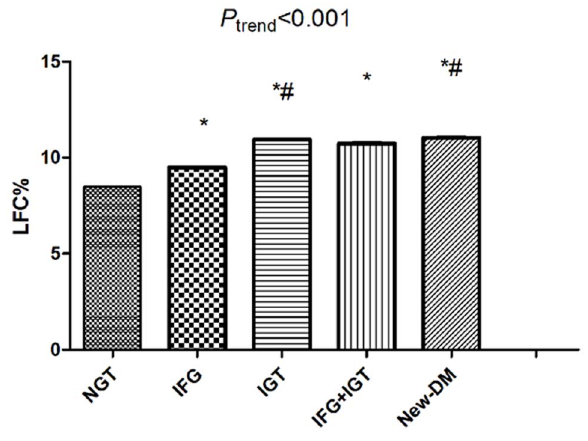
Figure 1. The liver fat content increases across the glucose profiles after adjustment for age and gender. *: vs. NGT; # : vs. IFG; LFC: liver fat content; NGT: normal glucose tolerance; IFG: impaired fasting glucose; IGT: impaired glucose tolerance; DM: diabetes mellitus.